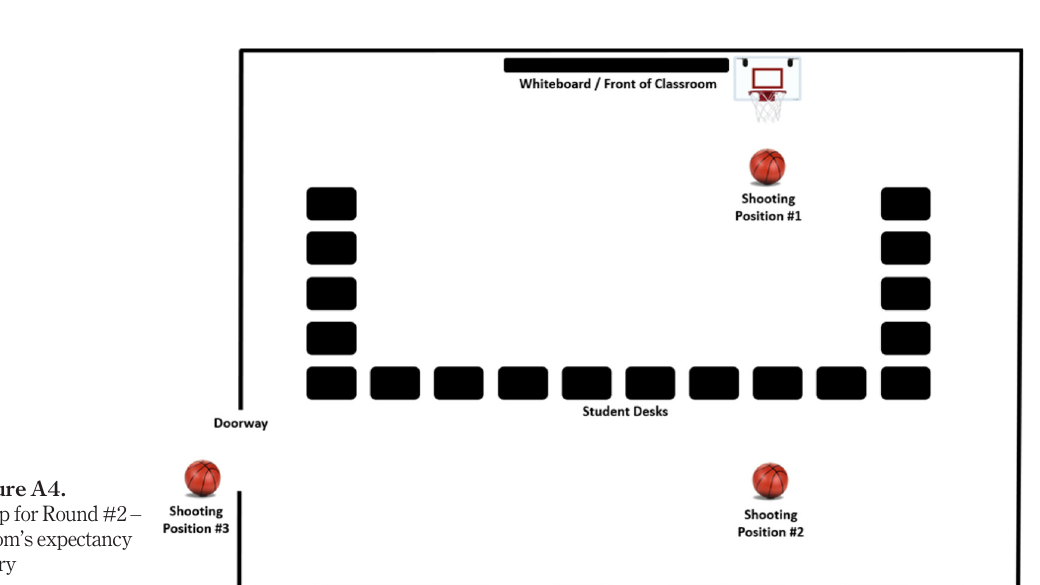
Figure A3. Setup for Round #1